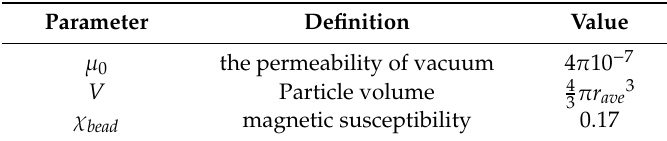
Table 1. Parameters’